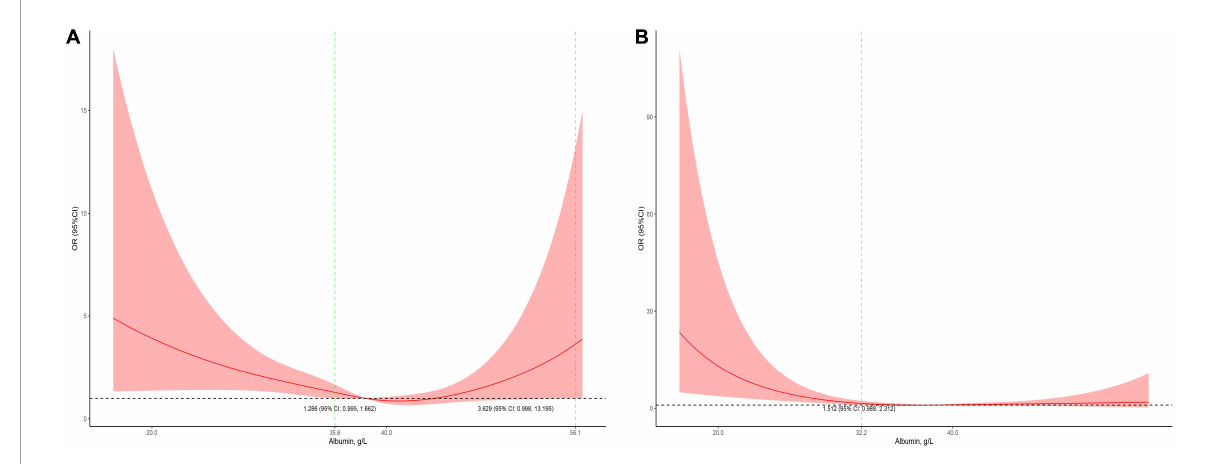
FIGURE4 Stratified analysis for the association between serum albumin levels and mortality ( A, subgroup analysis in male patients; B , subgroup analysis in female patients). The models were adjusted for age, race, admission form emergency department, cardiac surgery, PO 2 , PCO 2 , shock index, RR, bilirubin, eGFR, mechanical ventilation, inotropes, AKI, and PRISM.